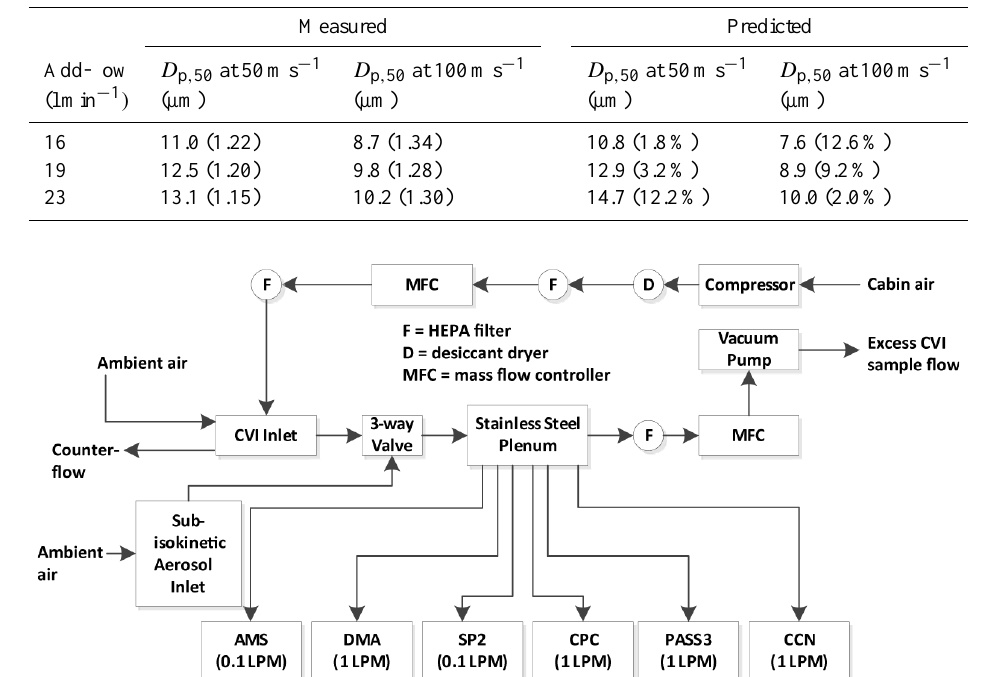
Table 1. Cut size behaviour of the CVI inlet at different simulated air velocities and add-flow rates. Results are shown for wind tunnel experiments and theoretical calculations based on a numerical integration technique described by Anderson et al. (1993) using a C 1 value of 1.25. Values in parentheses in the “Measured” columns correspond to the cut sharpness defined as ( D p , 69 / D p , 31 ) 1 / 2 . Values in parentheses in the “Predicted” columns signify the percent error between measured and predicted values.